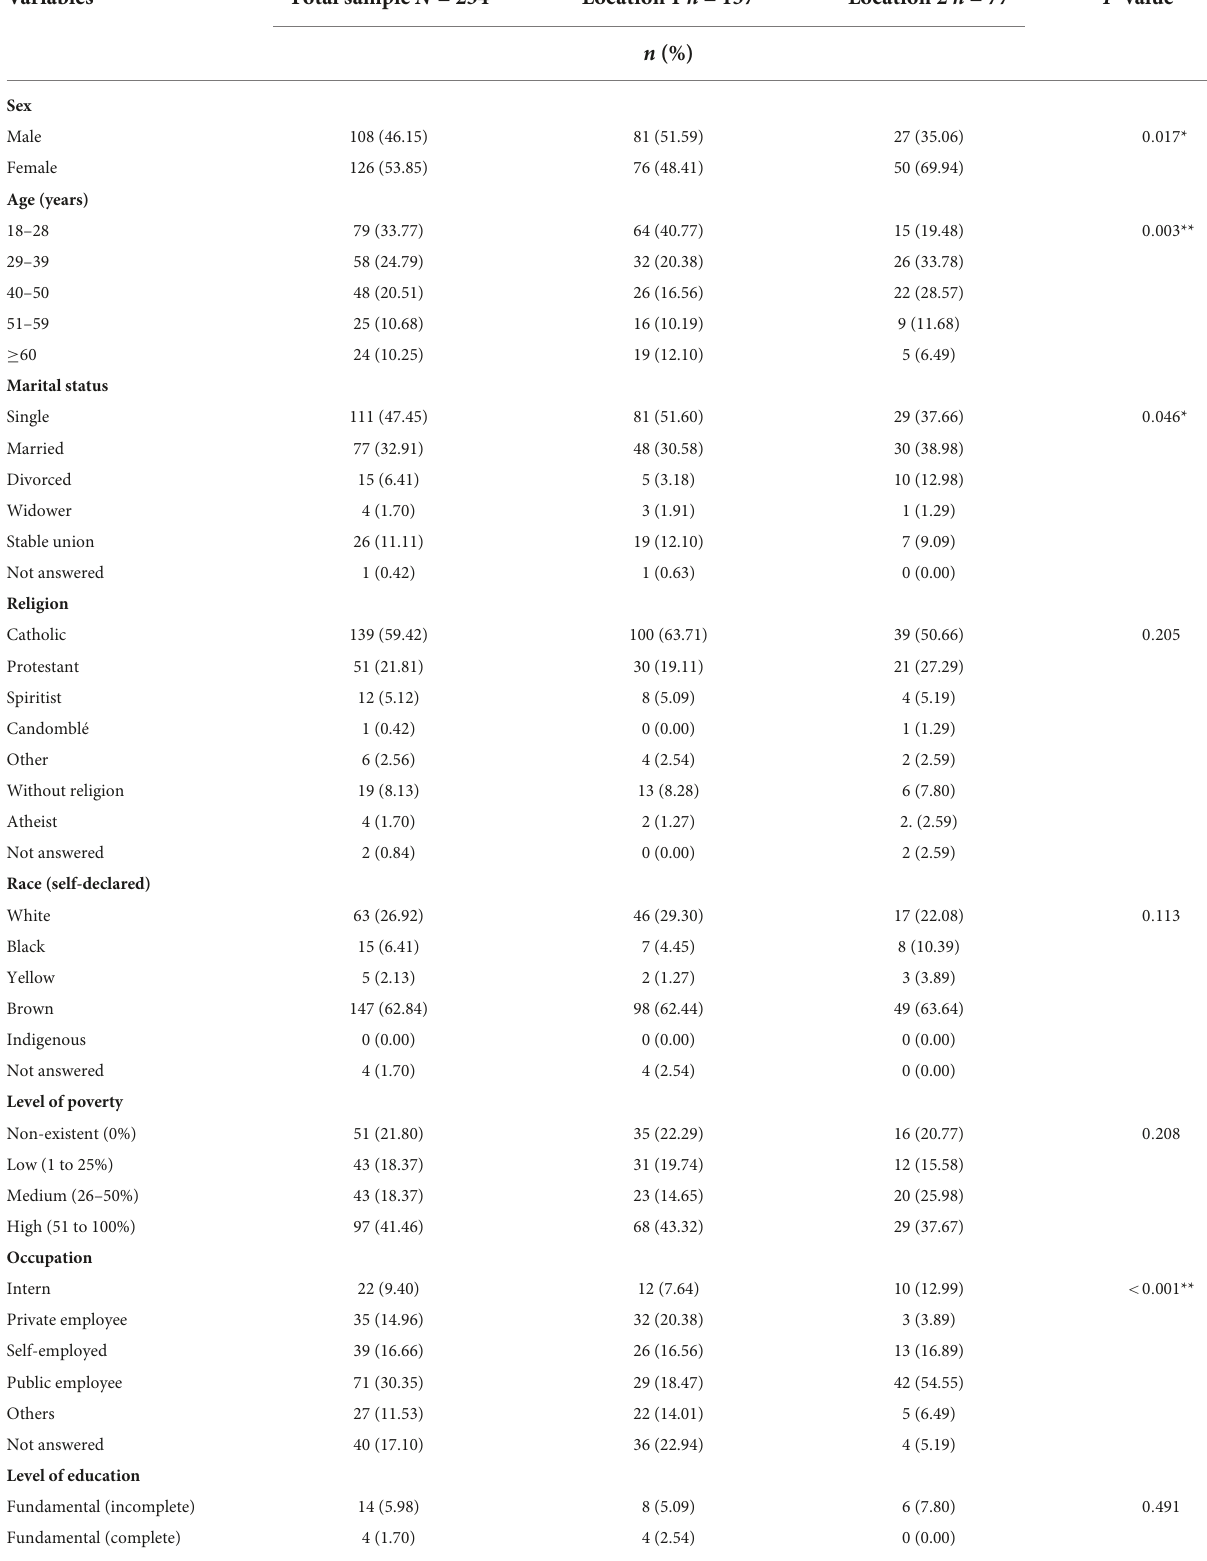
TABLE 1 Sociodemographic characteristics of